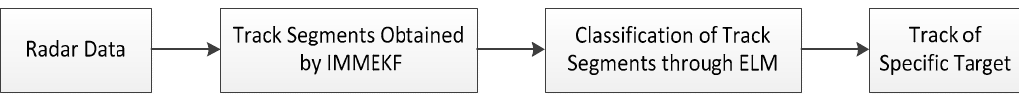
Figure 4. Flow graph of the continuous tracking method based on IMMEKF combined with ELM.